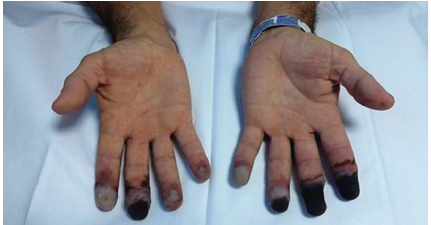
Figure 1: Necrotic lesions on the distal phalanges.